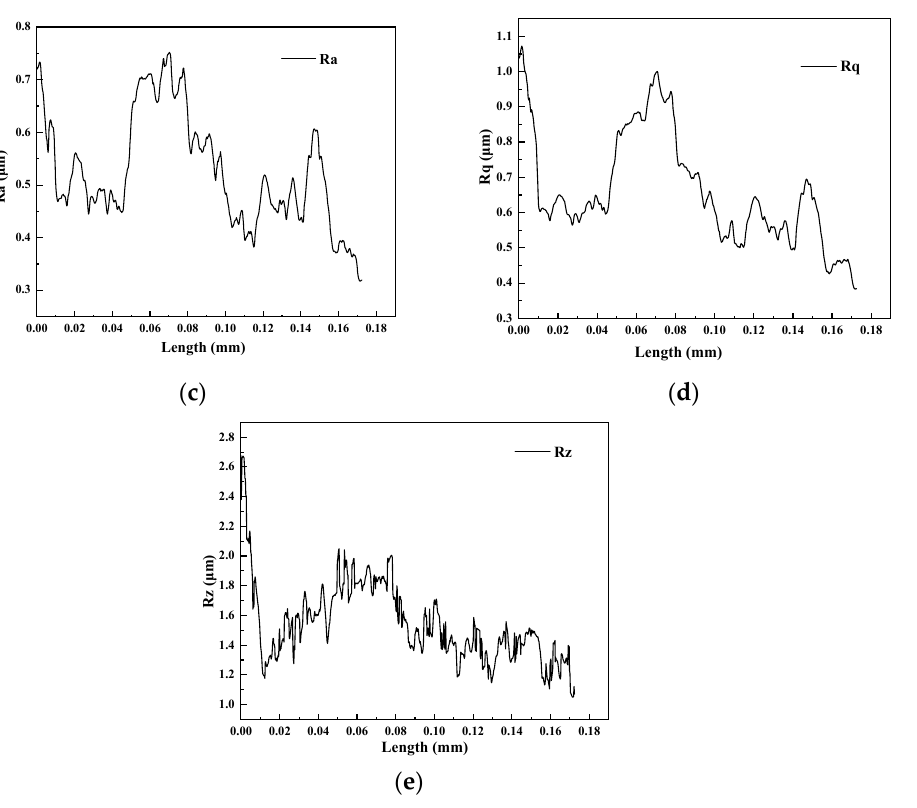
Figure 2. White light interference observation on the inner surface of after rolled pipe. ( a ) topography; ( b ) 3D morphology; ( c ) Ra ; ( d ) Rq ; ( e ) Rz .